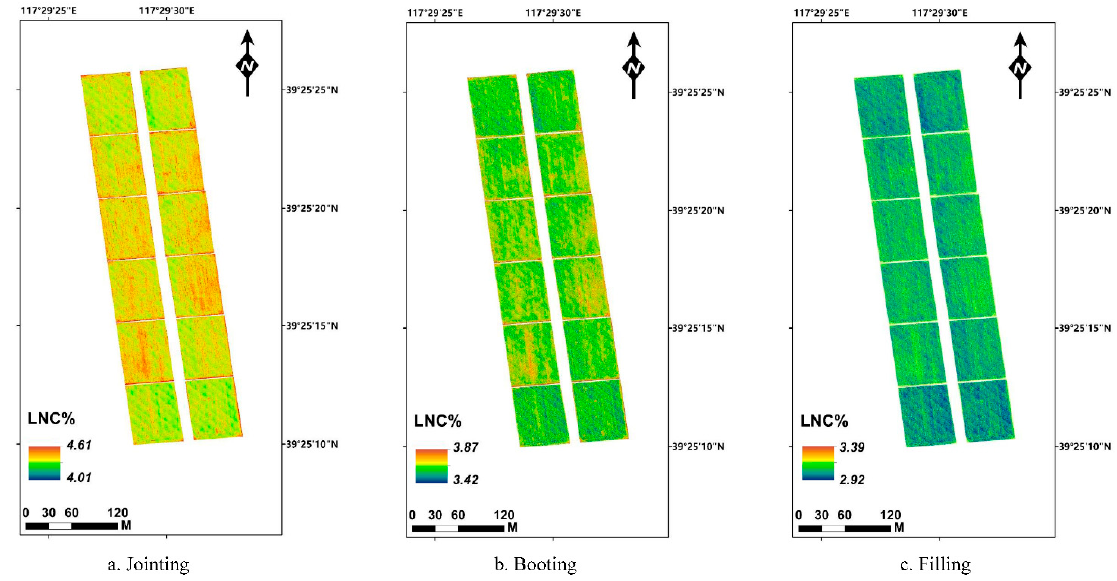
Figure 14. Spatial distribution of LNC in the Rice Canopy based on the SPA-RIDGE method.